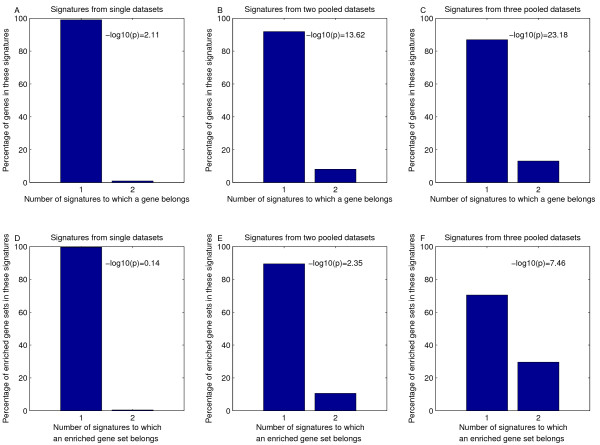
Histograms indicating the percentage of genes (A-C) and enriched gene sets (D-F) that overlap between two signatures. A and D) Median histogram and hypergeometric p-value across every pairwise comparison of signatures from single datasets. B and E) Median histogram and hypergeometric p-value across every pairwise comparison of signatures from 2 pooled datasets C and F) Average histogram and hypergeometric p-value across every pairwise comparison of signatures from 3 pooled datasets. We only considered the comparisons of pooled datasets that do not overlap in terms of samples, e.g. the comparison of the signatures from 'Des Loi' and 'Des Paw' is excluded to avoid any bias.